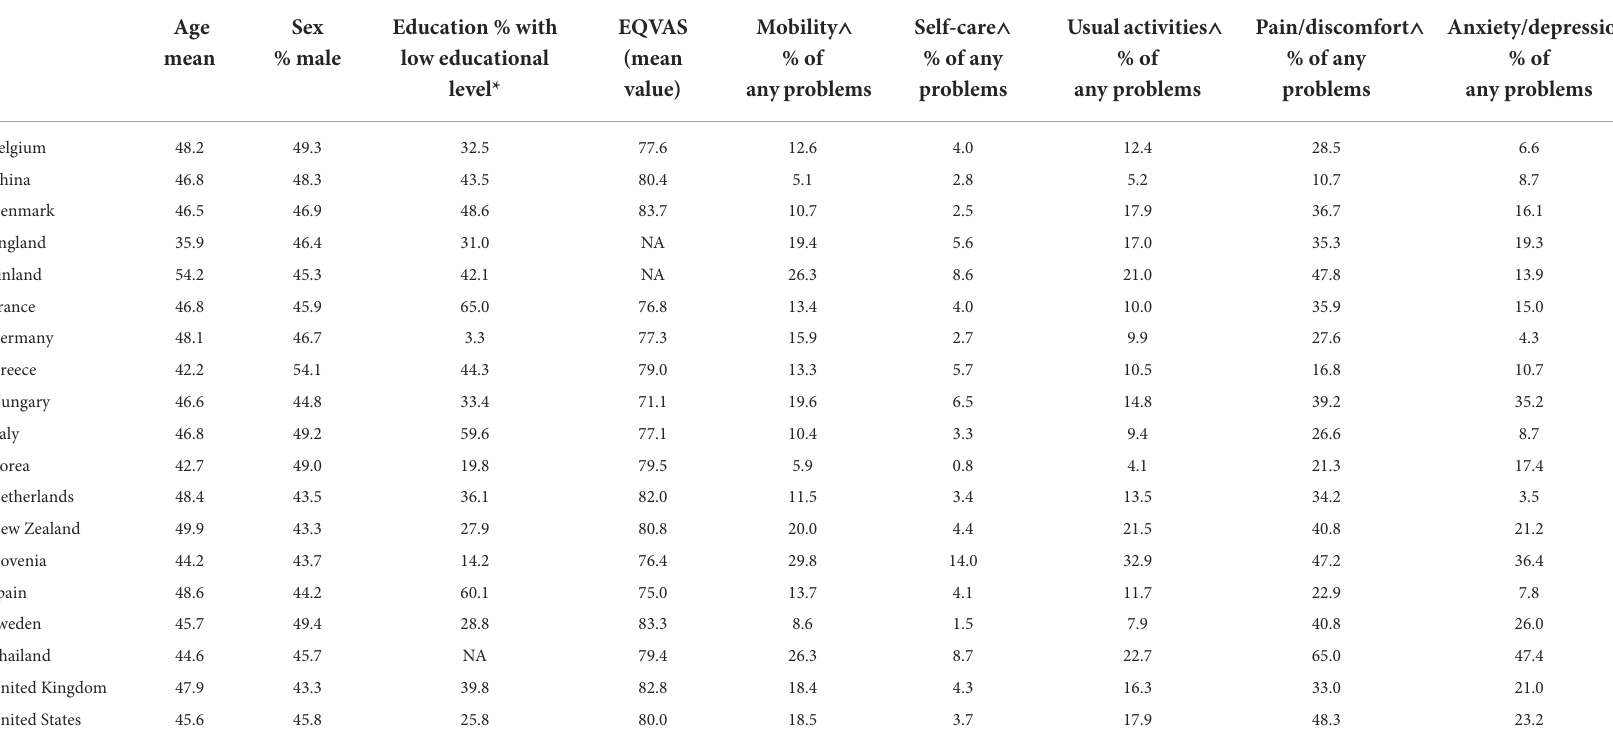
TABLE 2 Summary sample characteristics in 18